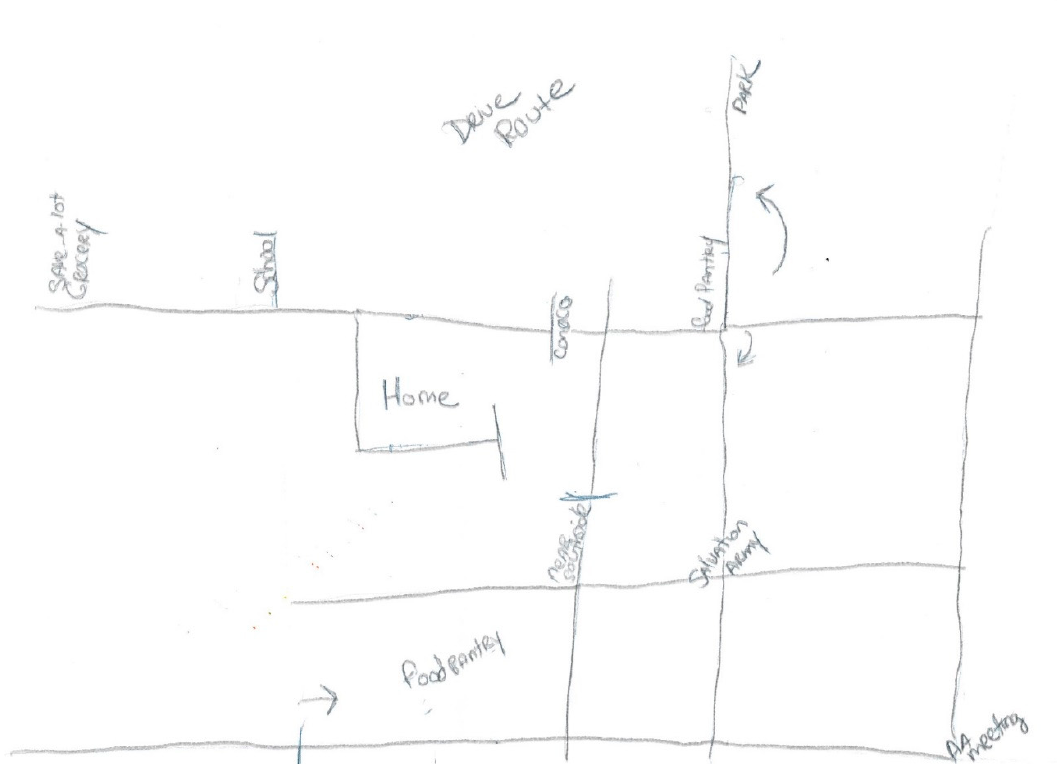
Figure 4. Dori’s map.